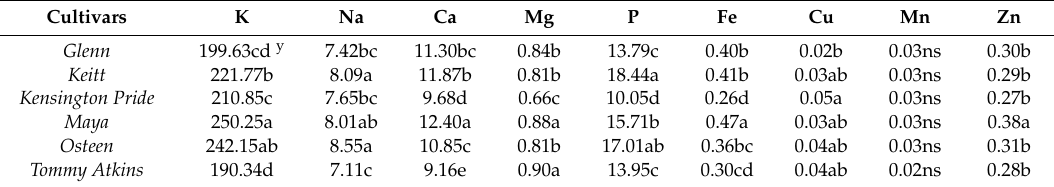
y The values marked with di ff erent letters in the same column indicate significant di ff erences according to Tukey’s test ( p ≤ 0.05); ns: not significant. Data are mean values ( n = 30). The values marked with di ff erent letters in